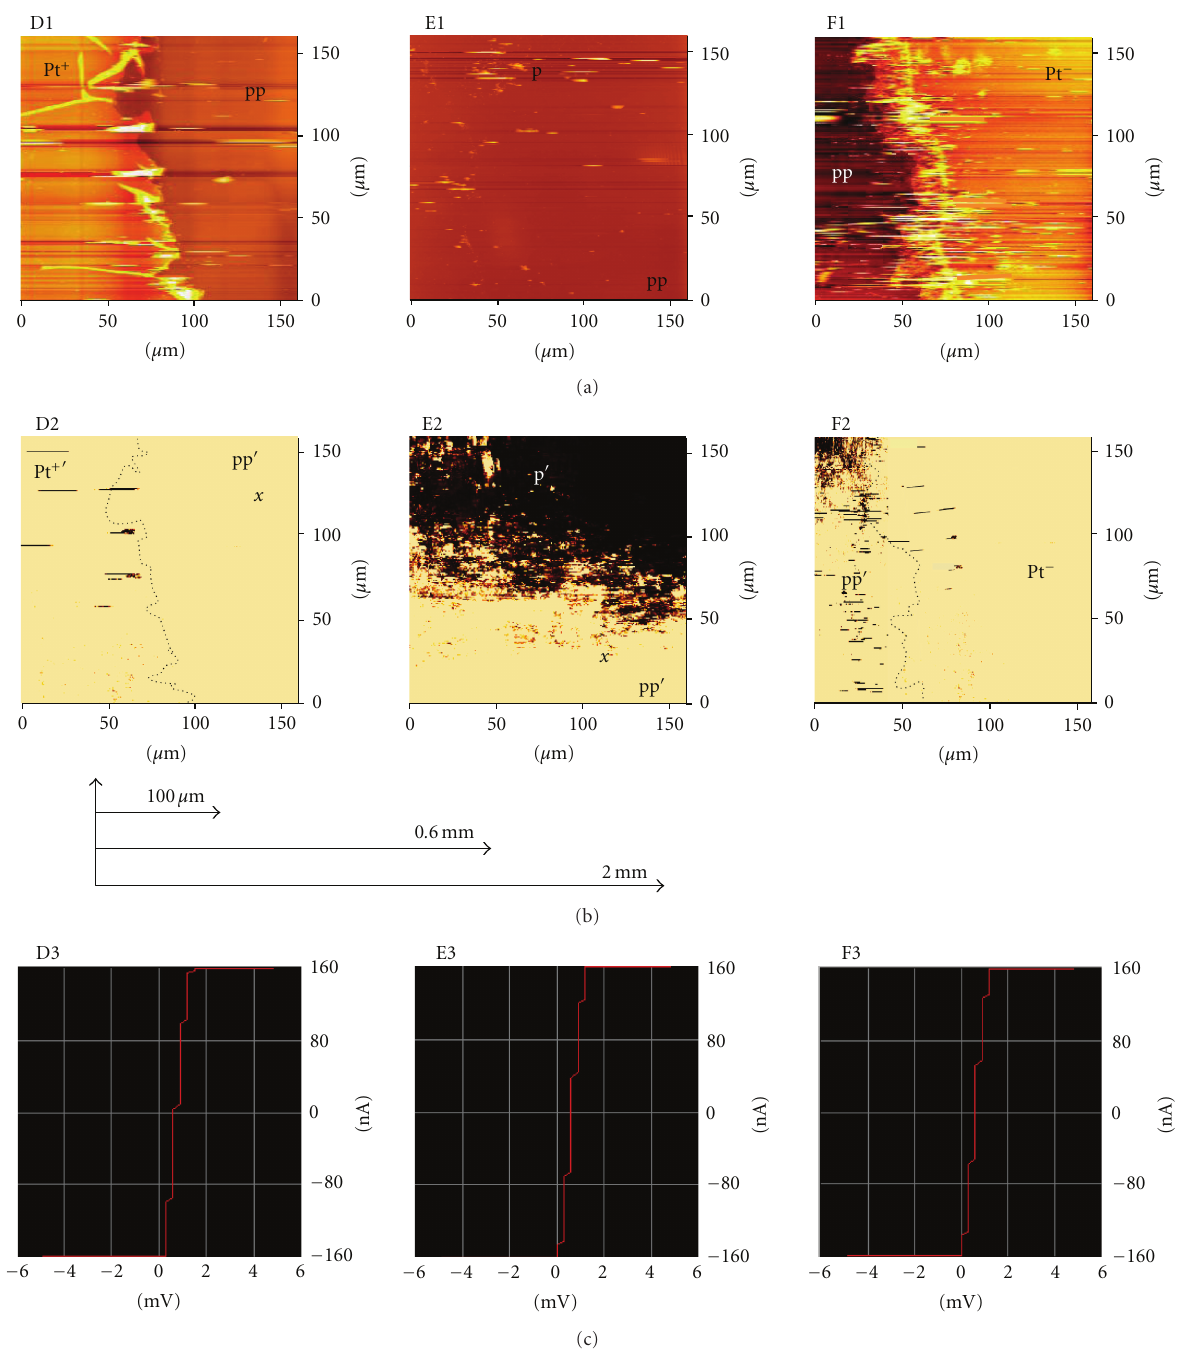
Figure 7: Topographical images (a), current images (b), and I-V curves (c) simultaneously obtained at the same position corresponding to the positions D, E, and F in Figure 3(b). Wherein portions pp and pp (cid:2) are polymerized layer and portions p and p (cid:2) are unpolymerized layer of the PNN monomolecular layer, and regions Pt + , Pt + (cid:2) , Pt, and Pt −(cid:2) are Pt electrodes. The I-V curves D3, E3, and F3 were obtained using the AFM tip covered with Au at cross-marks on D2, E2, and F2 in (b),